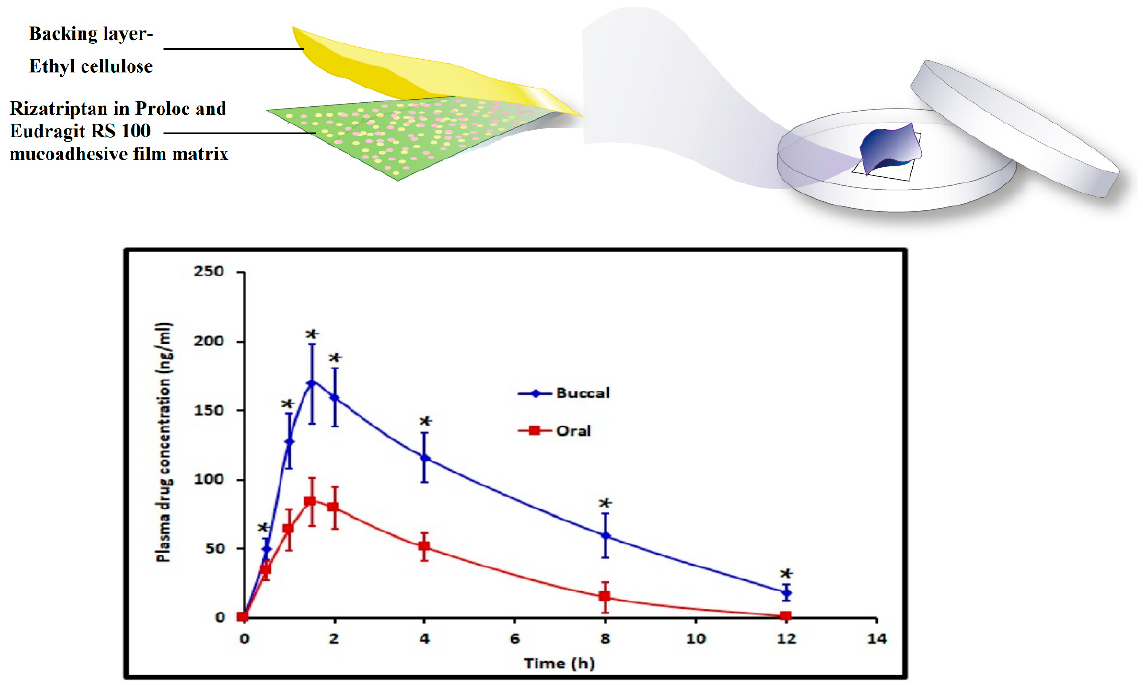
Figure 2. Development of rizatriptan loaded hydrogel-based mucoadhesive buccal film and enhanced buccal permeation displayed by the film compared to oral solution containing equivalent dose (adapted from [25], published by MDPI, 2021). *, Statistically different at p < 0.005.